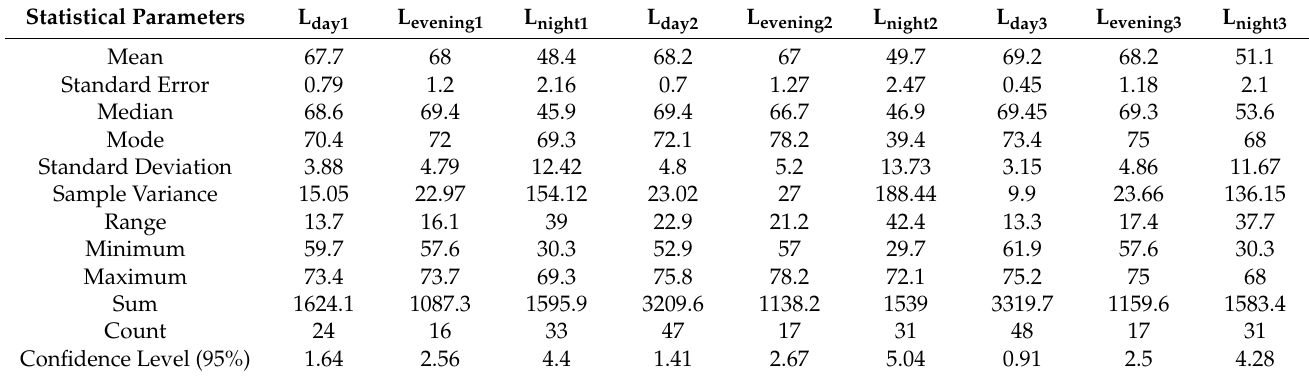
Table 4. Descriptive statistics of experimental noise level measurements in both ICUs for all days considering the day, evening, and night periods.